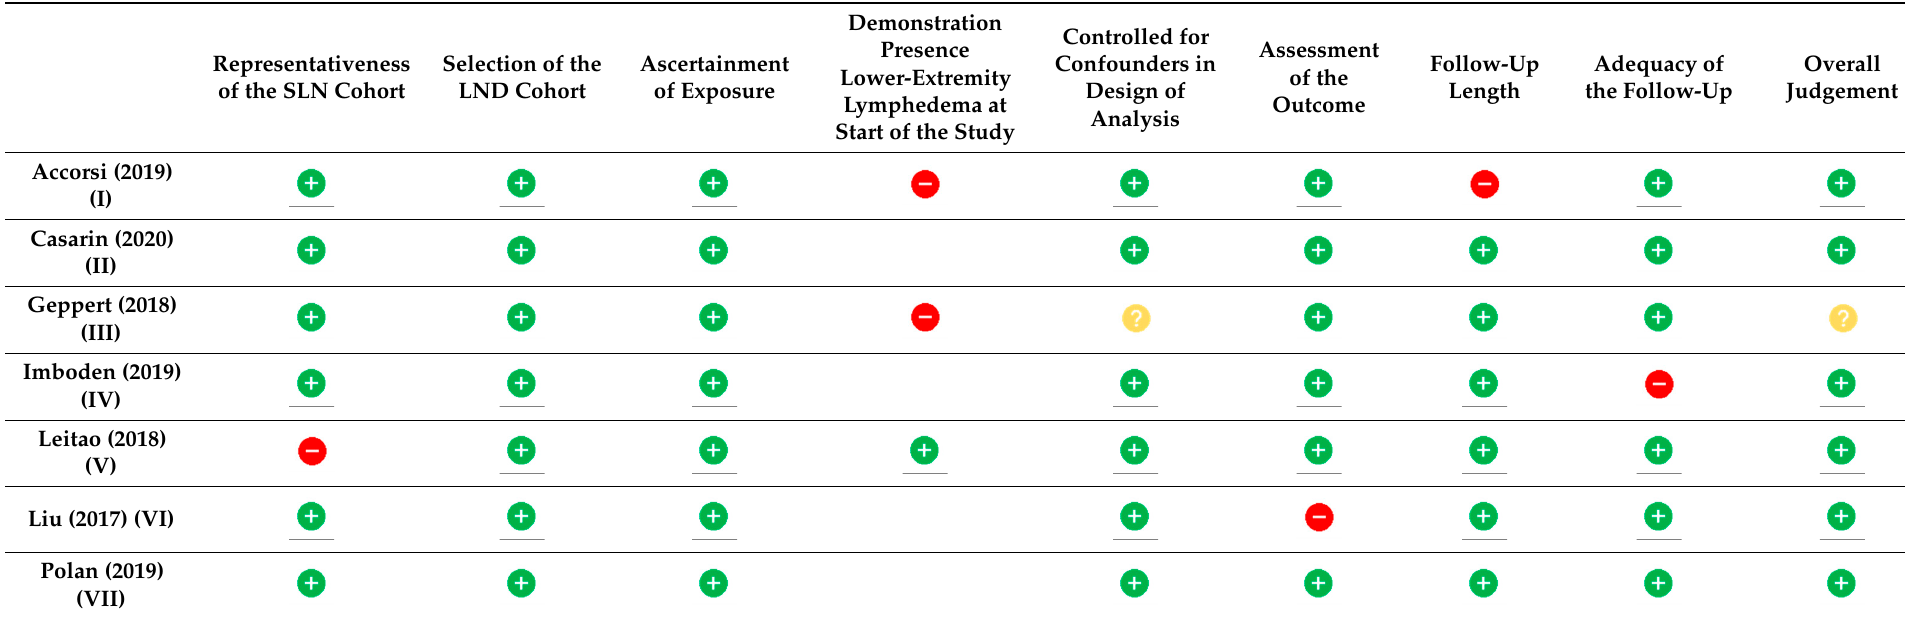
Table 3. Risk of bias summary: review authors’ judgements about each risk of bias item for each included study using the Newcastle-Ottawa Scale.